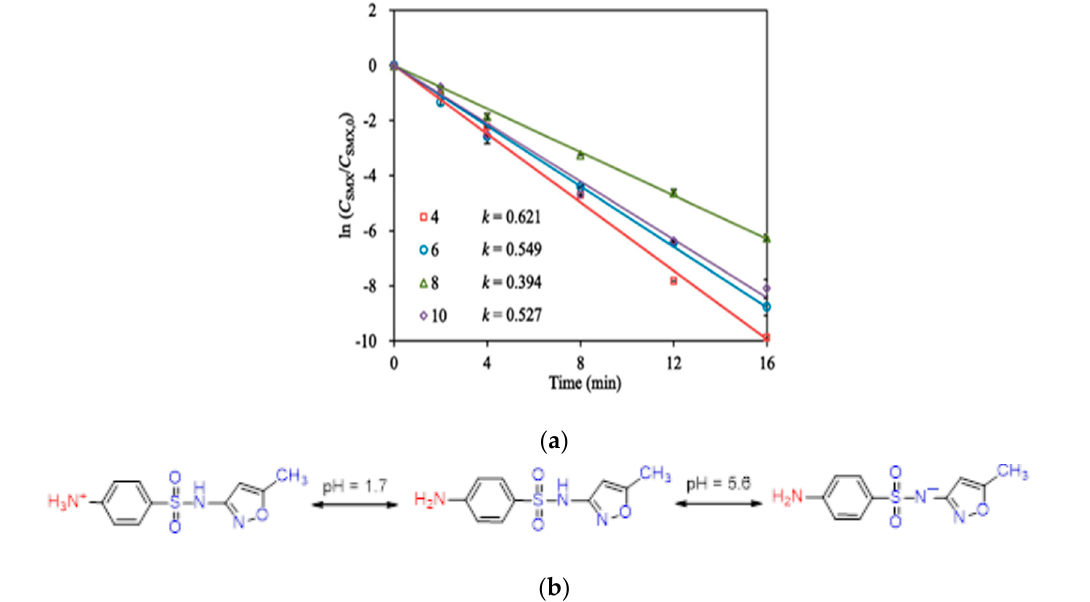
Figure 3. ( a ) Variations in the photocatalytic degradation of SMX concerning change in the pH of the aqueous solution (Reproduced from [22] (with the permission order number: 5114291052991); ( b ) charge variation in the structure of SMX with respect to the change in pH from acidic to alkaline in the aqueous solution (adapted from [64], Copyright Year 2015, Journal of Hazardous Material @ Elsevier with the permission order number: 5114720328428).